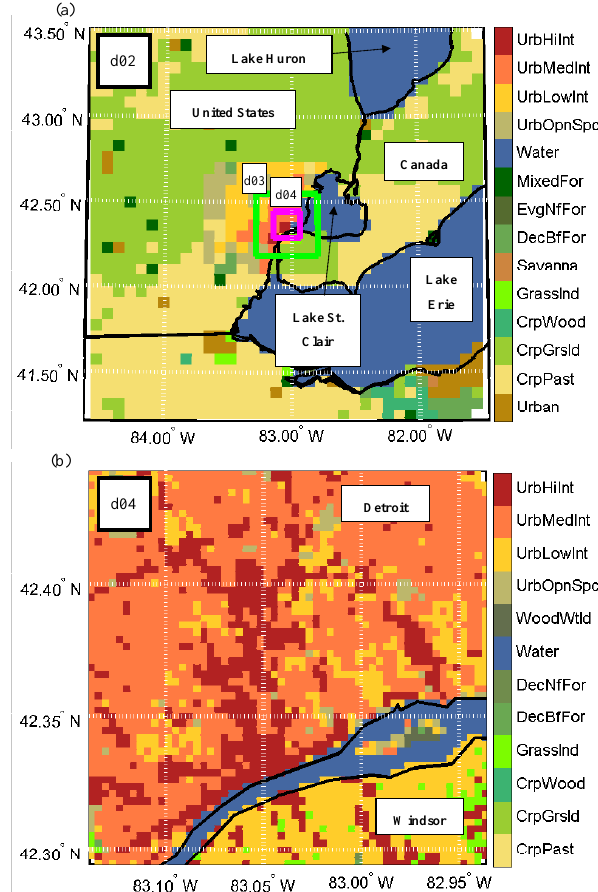
Fig. 1. Surface land cover type over the 2nd (a) and 4th (b) grids of the model domain over Detroit-Windsor (see Appendix A for abbre- viations). Outlines of the 3rd grid (d03: green) and 4th grid (d04: magenta) appear in (a). The 1st grid (d01, not shown), is centered at 42.26 ◦ N, 93.10 ◦ W and extends across approximately 64 ◦ longi- tude and 29 ◦